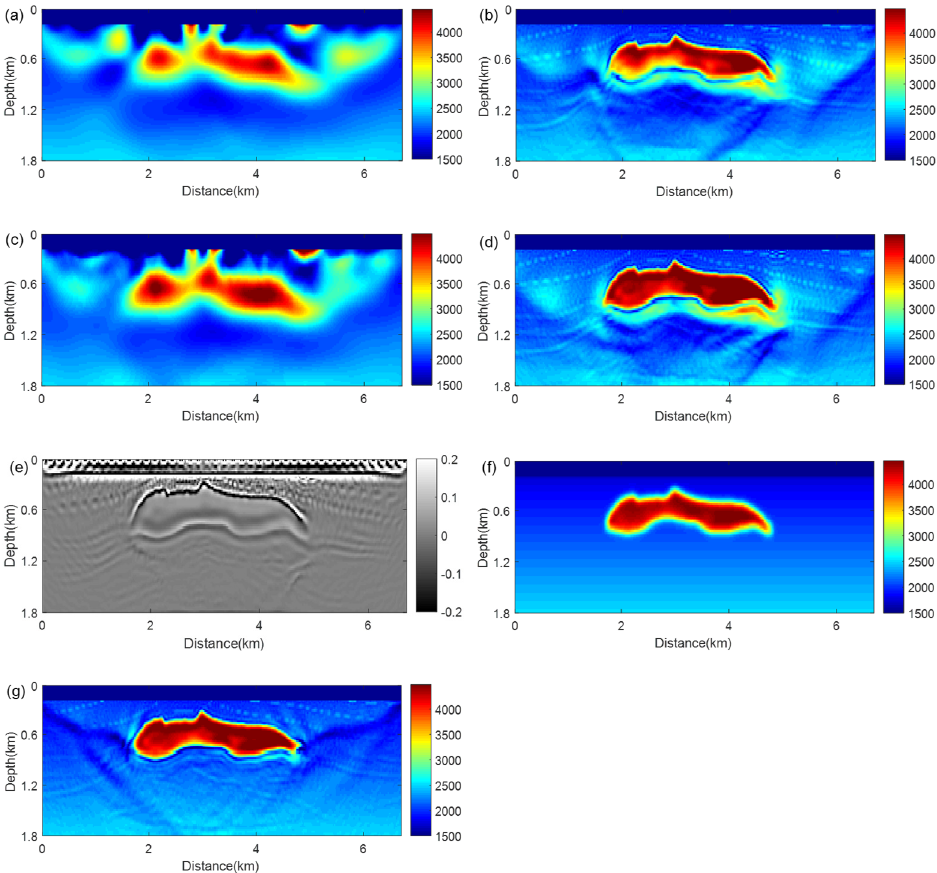
Figure 10. Inversion results with noisy data. ( a ) Conventional DEI result. ( b ) Conventional DEI + FWI result. ( c ) WDDEI result. ( d ) WDDEI + FWI result. ( e ) RTM imaging result using Figure 10d as the velocity model. ( f ) SGPD result. ( g ) Final inversion result of the proposed method.